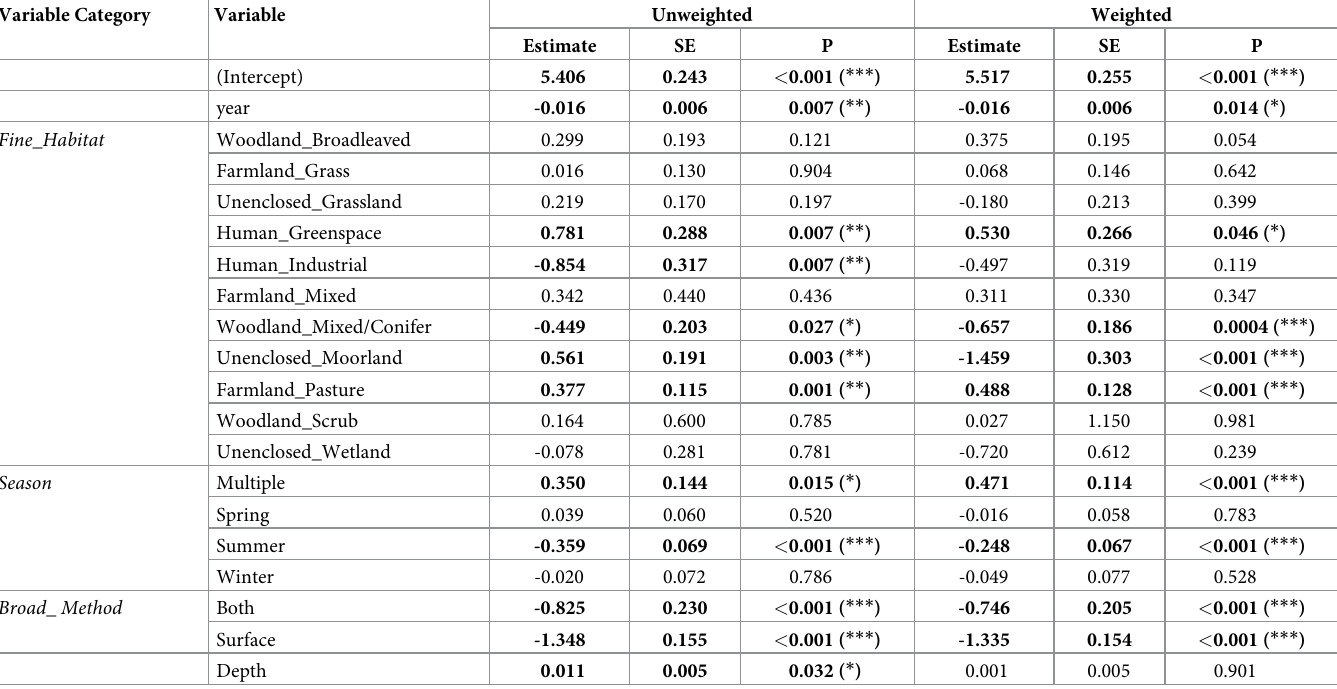
Table 4. Model 2 output of earthworm abundance. Estimates from Fine_Habitat Model 2, unweighted and weighted (by natural log of Sample Extent + 1), compared to the base of Farmland_Arable, Autumn and Core. The level of significance is represented by: * p < 0.05; ** p < 0.01; *** p < 0.001, SE = Standard Error. Variable Category